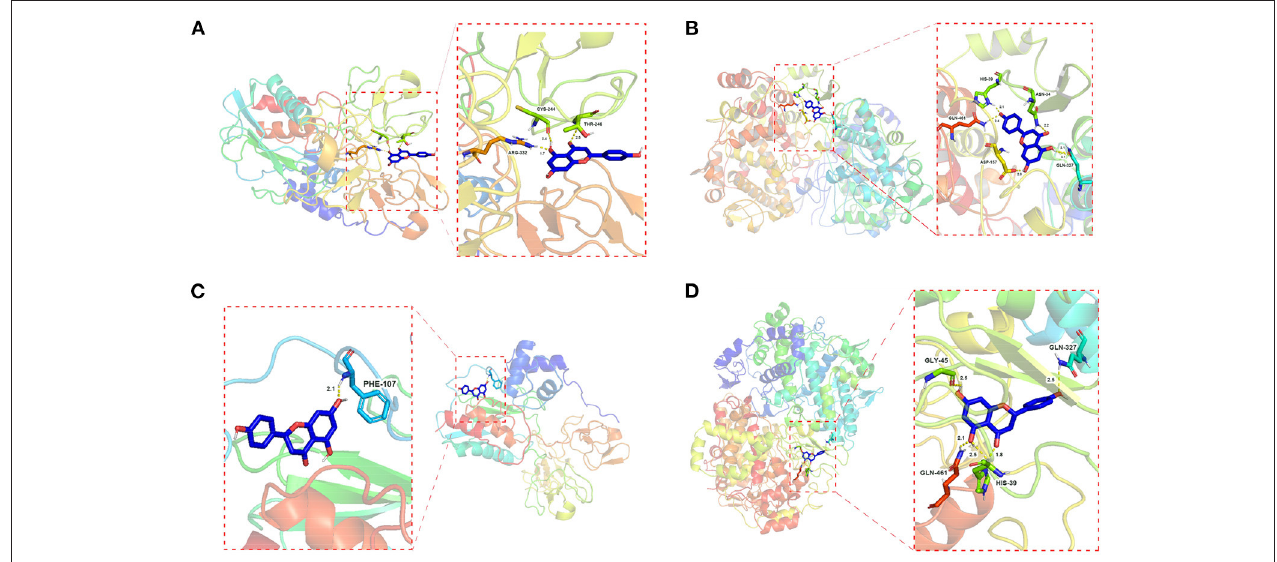
FIGURE 5 | Schematic (3D) representation of the molecular model of the active component combined with the target proteins. Components: apigenin. Target proteins: (A) MMP9; (B) PTGS2; components: naringenin. Target proteins: (C) MMP9; (D) PTGS2.